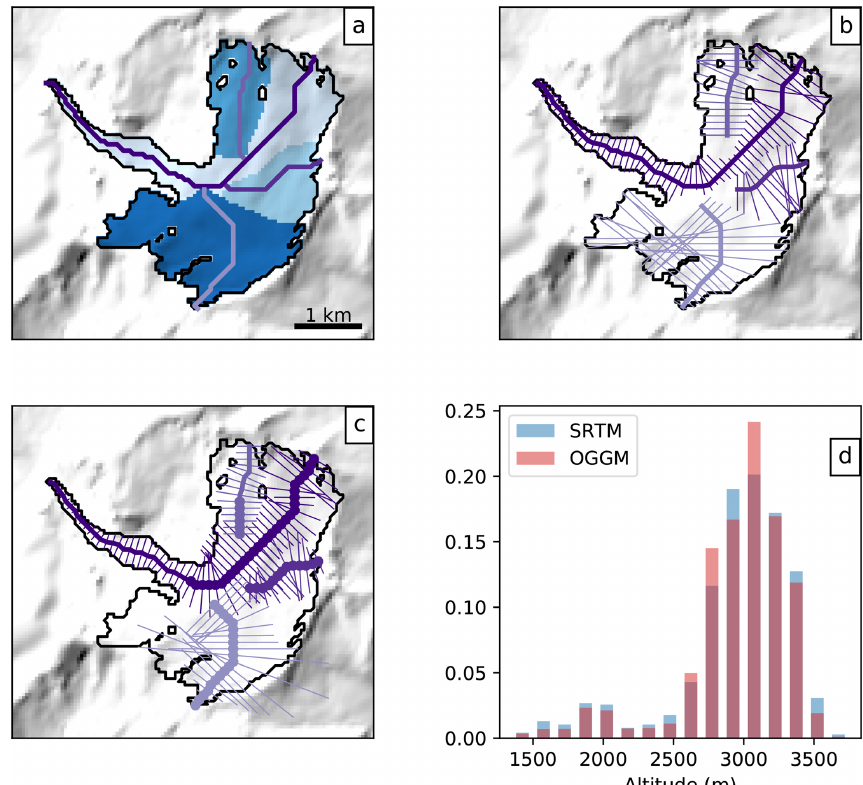
Figure 2. Example of the flow-lines’ width determination algorithm applied to the Upper Grindelwald glacier, Switzerland: (a) determination of each flow-line’s catchment area; (b) geometrical widths; (c) widths corrected for the altitude–area distribution – the bold lines represent the grid points where the cross section touches a neighboring catchment; and (d) the frequency distribution of the glacier area per altitude bin, as represented by OGGM and by the SRTM